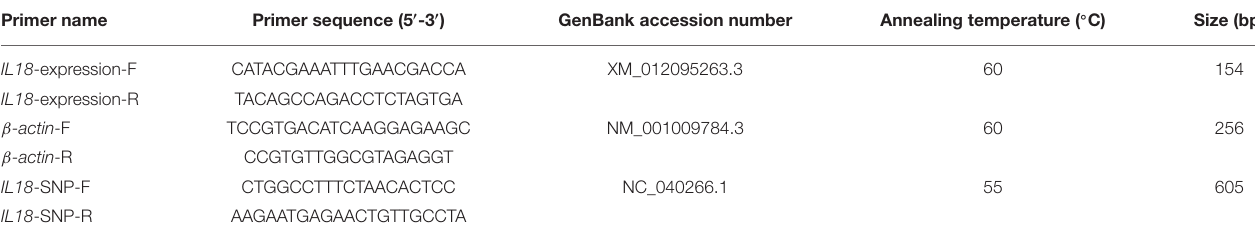
TABLE 1 | Details of primer sequences used for qRT-PCR and PCR amplification.